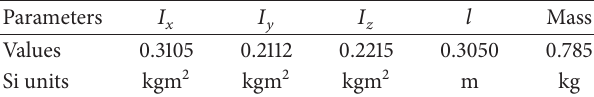
Table 5: Parameters of trirotor